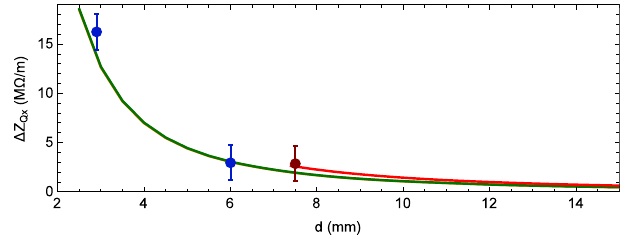
FIG. 7. Summary results of the quadrupole impedance vs magnetic gap d for IVU and DW. Blue dots and green solid line are measured data vs analytically obtained by Eq. (29) for the IVU case. Dark red dot and red solid line are for one DW.